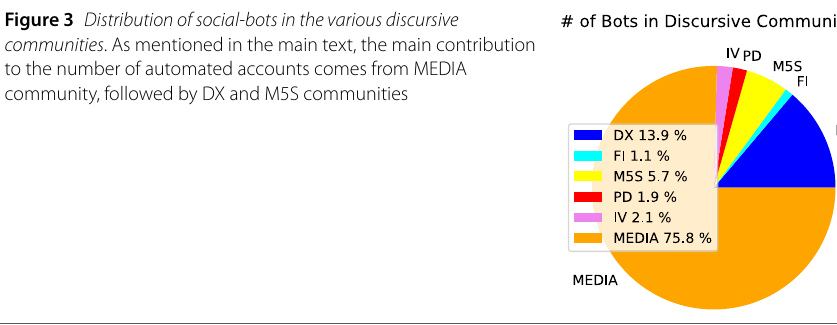
Figure 3 Distributionofsocial-botsinthevariousdiscursive communities . As mentioned in the main text, the main contribution to the number of automated accounts comes from MEDIA community, followed by DX and M5S